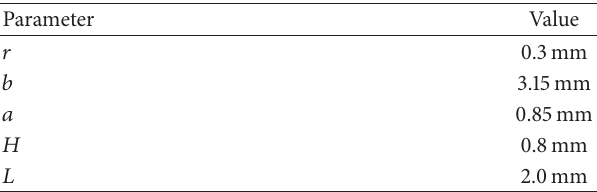
Table 2: Parameters of the folded slow-wave